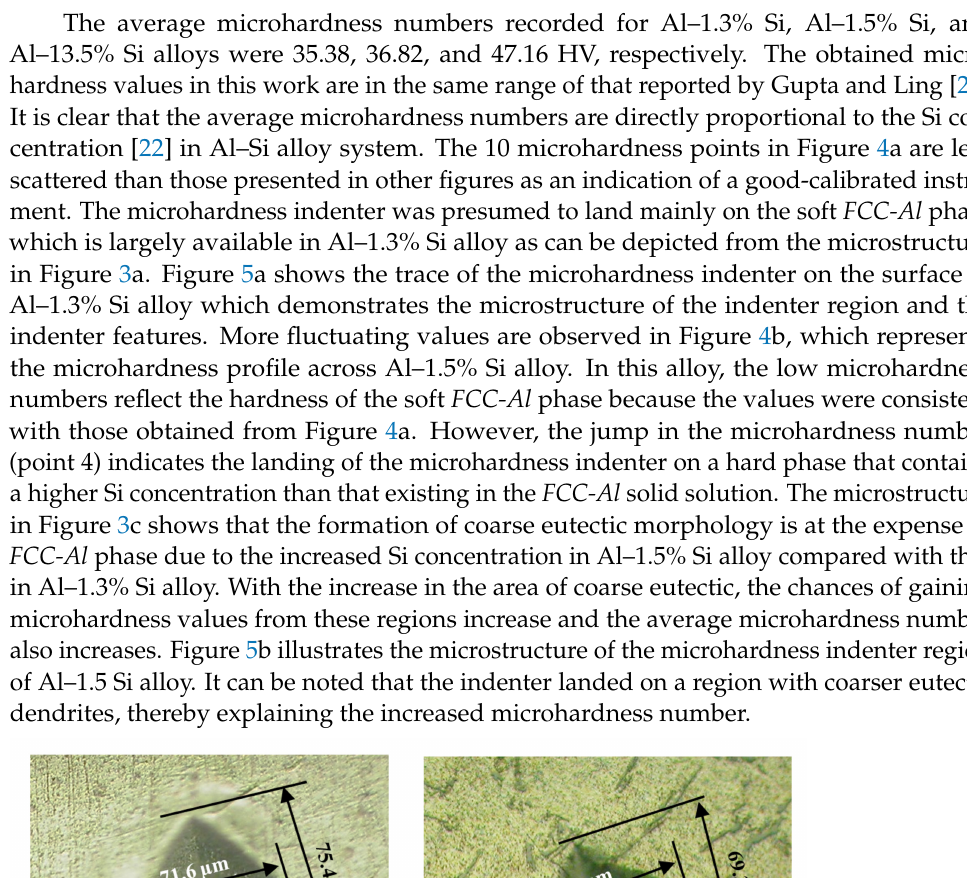
Figure 4. Microhardness values and average microhardness numbers for ( a ) Al–1.3%Si, ( b ) Al–1.5%Si, and ( c ) Al–13.5%Si alloys.